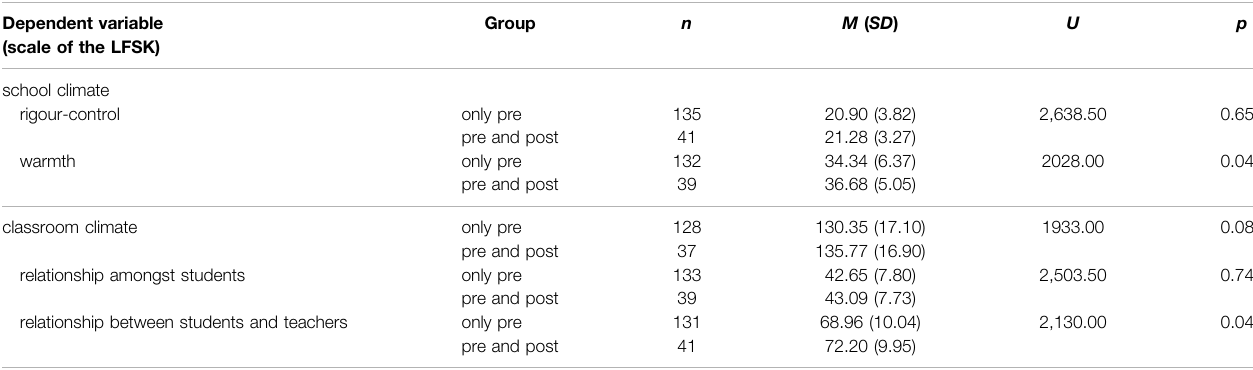
TABLE 6 | Differences according to Mann-Whitney-U-tests between pre-only-participants and pre- and post-participants regarding school and classroom climate at baseline. Dependent variable (scale of the LFSK)